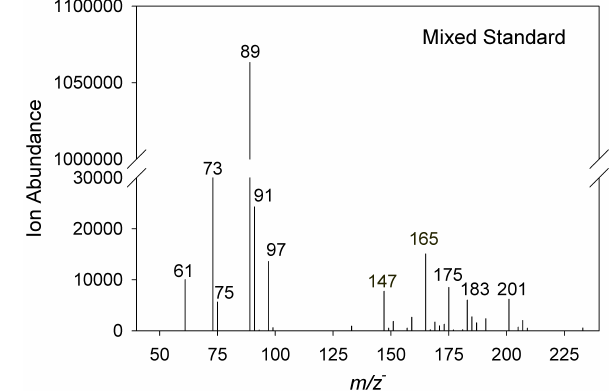
Fig. 4. FTICR-mass spectrum of the products formed from the 30min-reaction of glyoxal (3000µM) with OH radicals, detected in negative ionization mode.